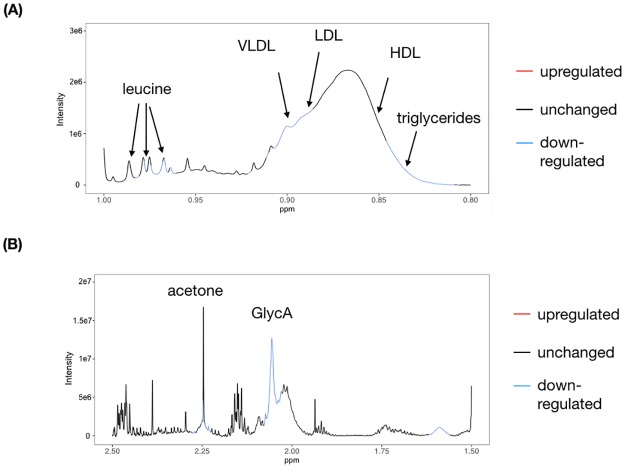
NMR spectral regions associated with Cluster 2.(A) Far-methyl region including signals from lipoproteins and branched-chain amino acids. (B) Downfield region from (A) which includes the GlycA inflammation marker and acetone.